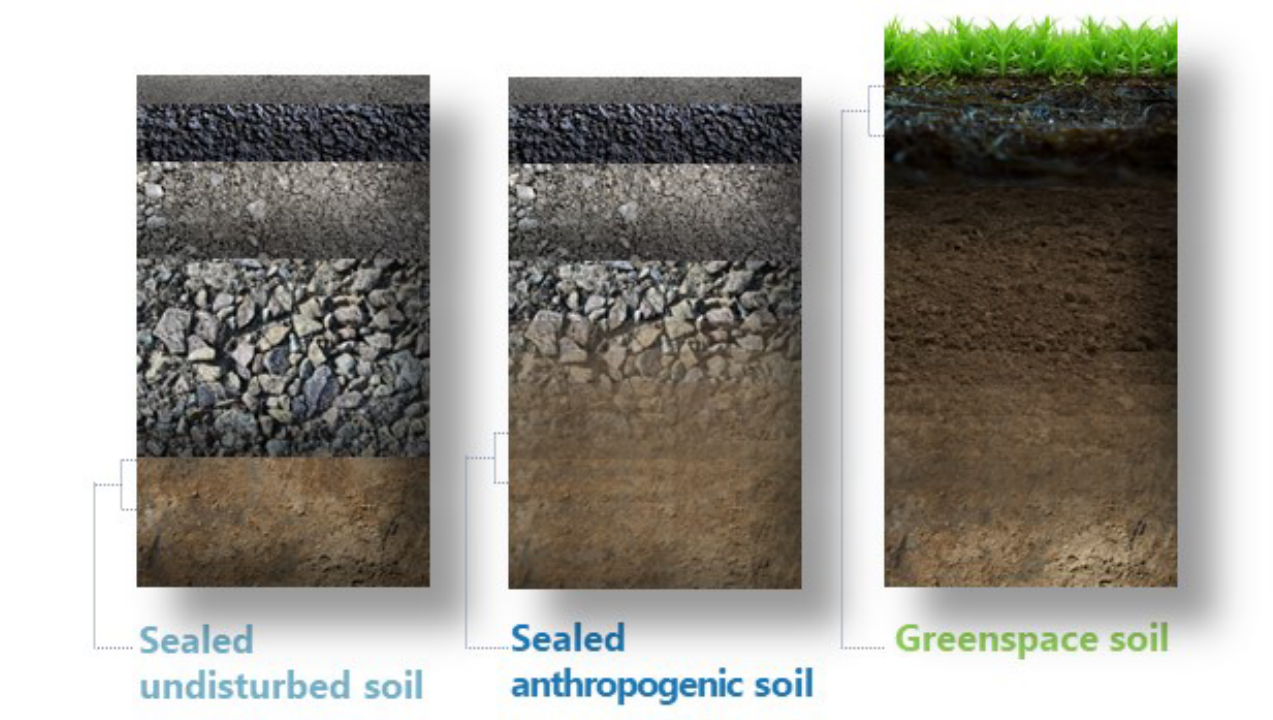
Figure 2. Diagram showing soil profiles and sampling depths of the three soil